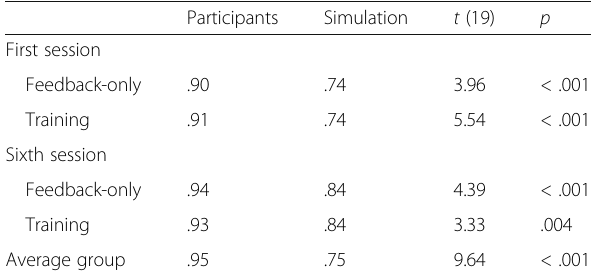
Table 1 Mean bidimensional correlations for participants ’ sketch maps and